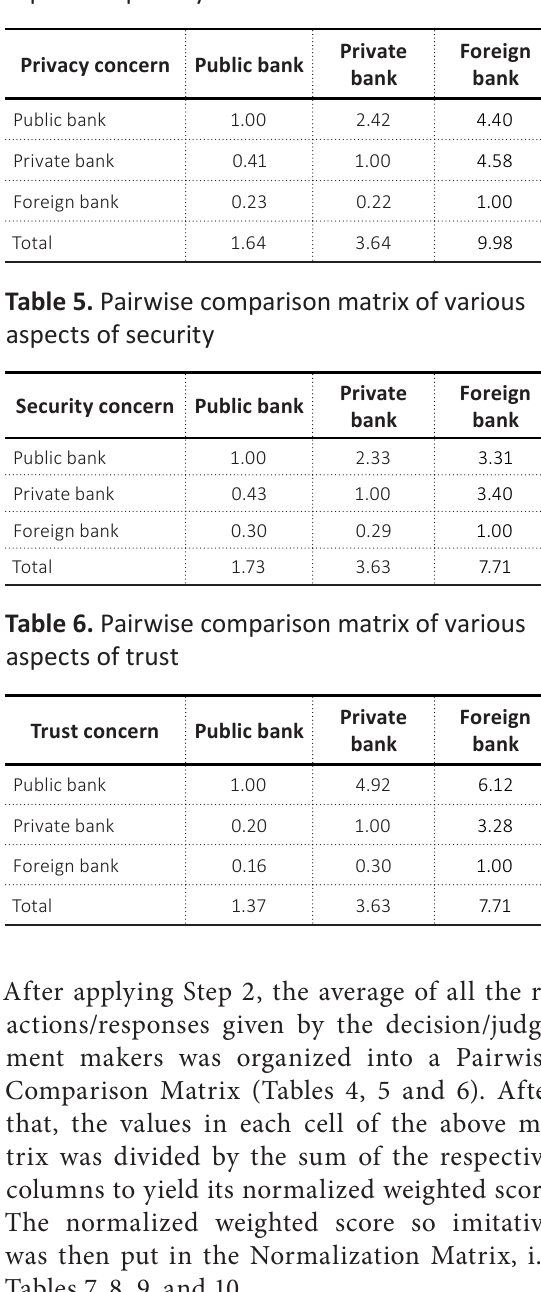
Table 4. Pairwise comparison matrix of various aspects of privacy